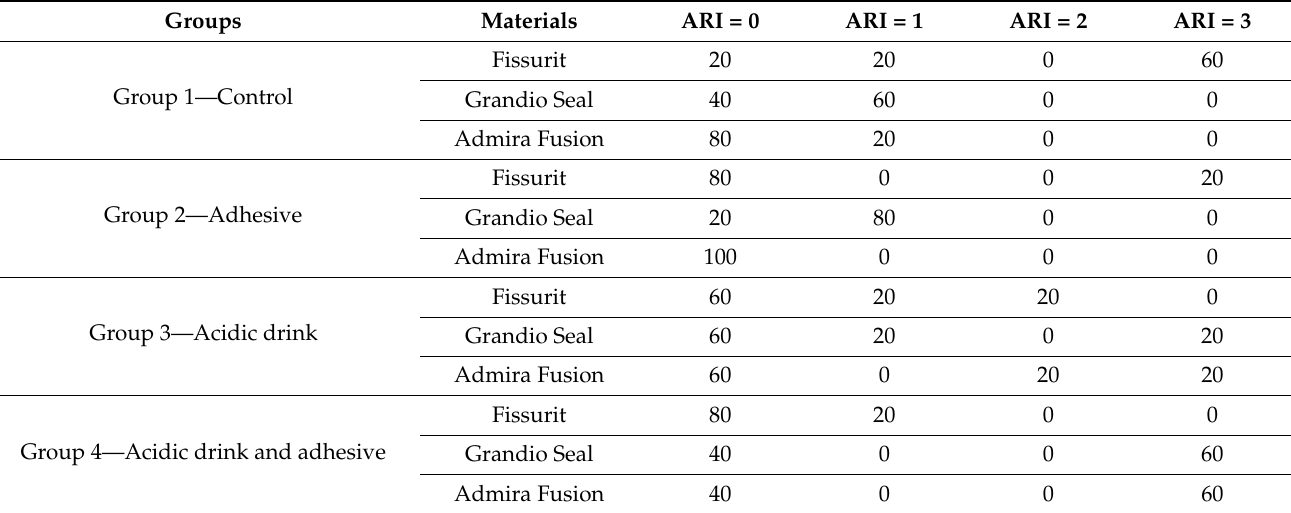
Table 3. Percentages of adhesive remnant index (ARI) for each material